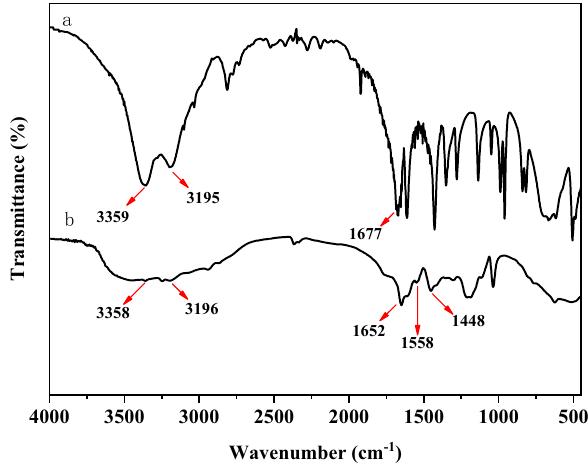
Fig. 2 a Infrared spectrum of acrylamide (AM). b PAA/PAM/ [DMAEMA]MA